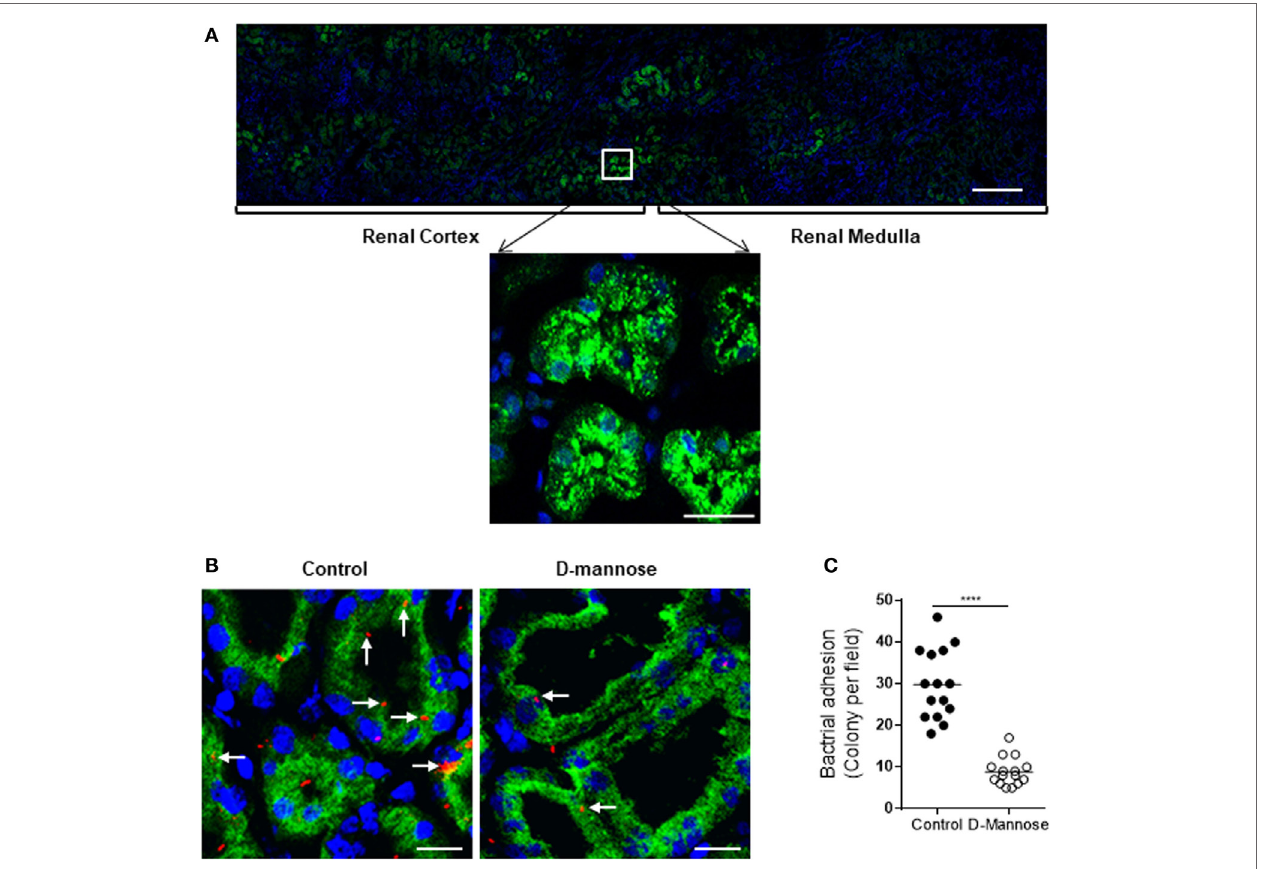
FigUre 8 | Man is required for type1 fimbriae-mediated in situ infection of human kidney tissues. (a) Fluorescence microscopy of normal kidney sections showing specific detection of Man (green) by fluorescein-labeled Galanthus nivalis lectin and counterstaining of nuclei with 4’,6-diamidino-2-phenylindole (blue). Man were mainly detected in the cortical and medullar tubules (top panel) and predominantly localized at the luminal surface of tubular epithelial cells (lower panel). Scale bars, 500 µm (top panel); 25 µm (lower panel). (B,c) Kidney sections were incubated with tri-iodothyronine and tetramethylrhodamine-labeled J96 (which were pre-treated with or without 5% d -mannose at 37°C for 30 min) for 1 h. Bacterial adhesion to tubular epithelium evaluated by fluorescence microscopy. (B) Represent images showing bacterial adhesion in the areas of cortical-medulla junction. Bacteria (red), Man (green), and nucleus (blue) are shown. Scale bars, 25 µm. (c) Quantification of bacterial adhesion to renal tissues corresponding to the images shown in (B) , results were expressed as number of colonies per field at × 200 magnification. Data were analyzed by unpaired two-tailed Student’s t -test ( n = 15 viewing fields from three kidney sections per group). **** P <